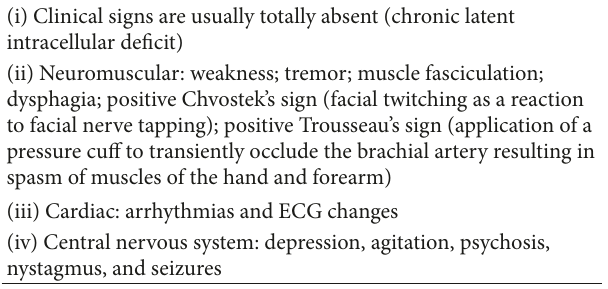
Table 4: Clinical symptoms and signs of magnesium